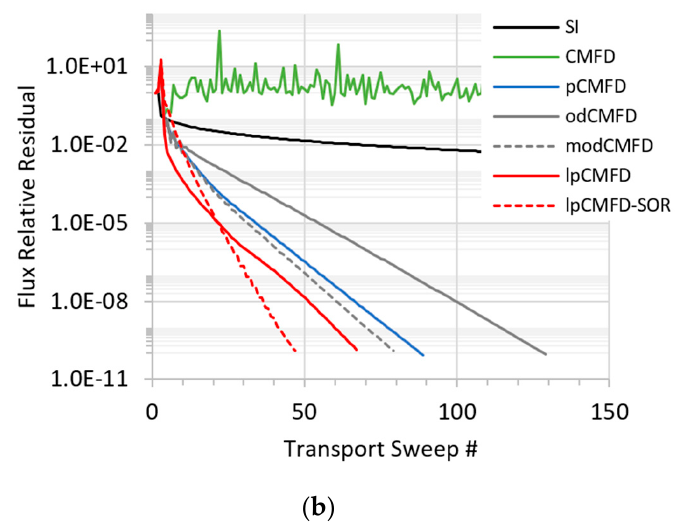
Figure 7. Results of the 1D iron-water problem. ( a ) Convergence, step characteristic (SC); ( b ) Convergence, diamond difference (DD).